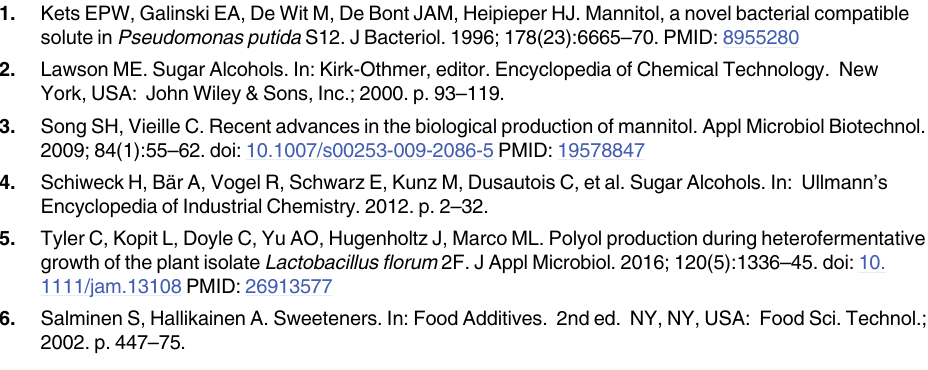
S1 Fig. HPLC Chromatogram of sterile MRS broth (2% w/v of glucose) reveals the presence of fructose and sucrose traces.